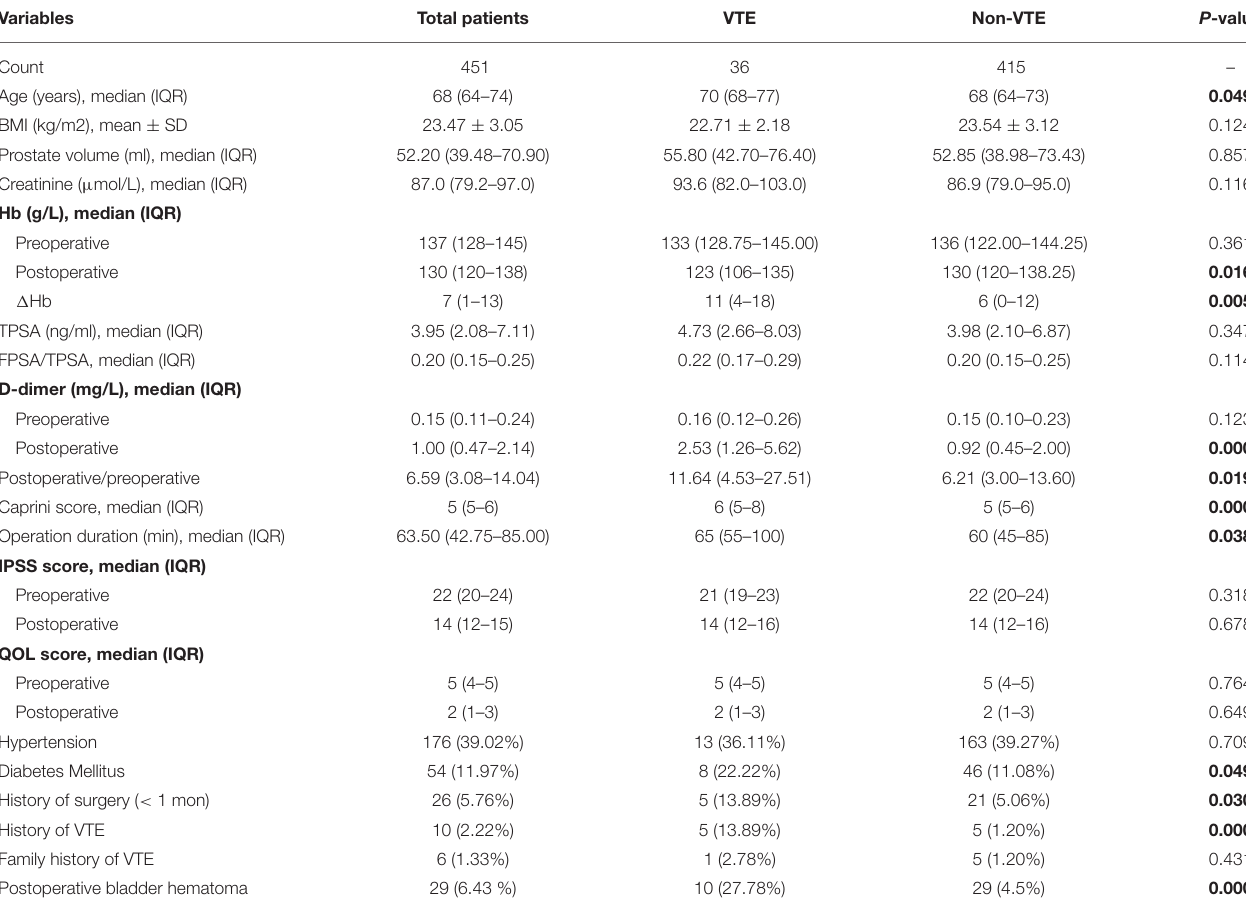
TABLE 1 | Baseline demographic and clinical